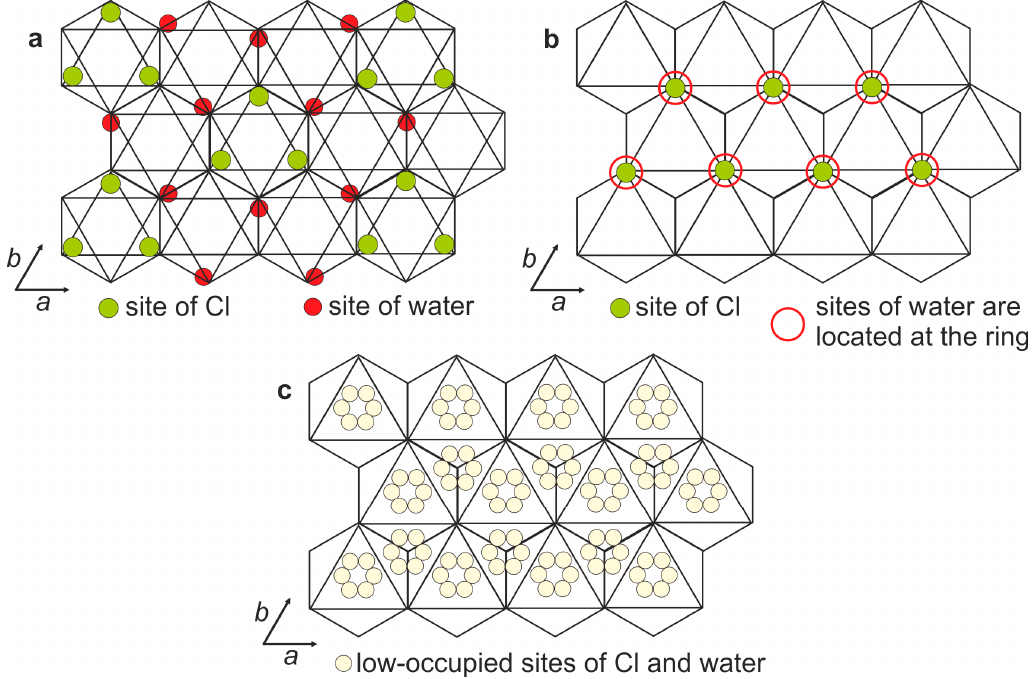
Figure 3. Structural model suggested for chlorine-bearing LDHs by ( a ) [9]; ( b ) [25] and ( c ) [26]. Note that interlayer sites are